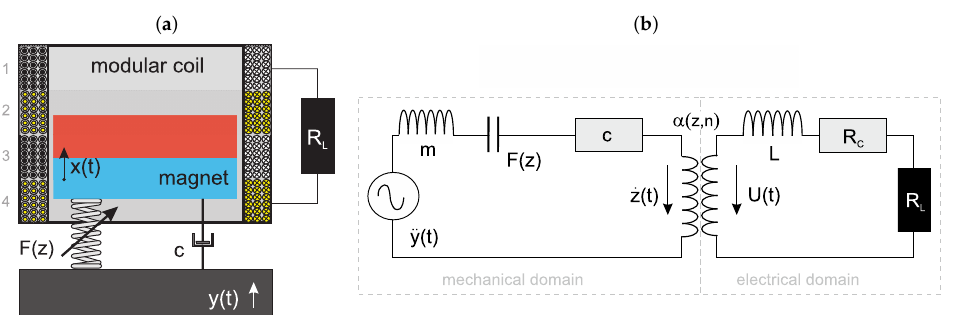
Figure 3. Mechanical model ( a ) and a coupled electromechanical model representation of the electro- magnetic vibration transducer ( b